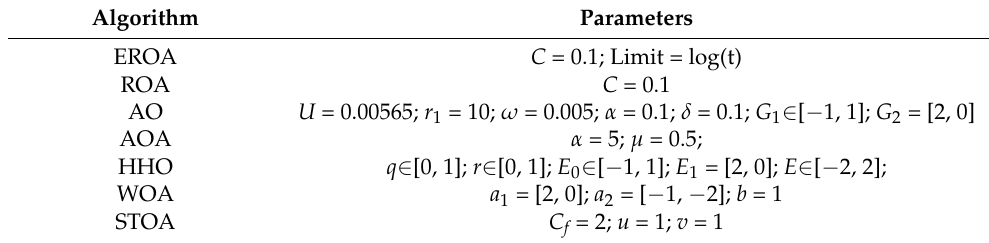
Table 1. Parameter settings for the comparative algorithms. Algorithm